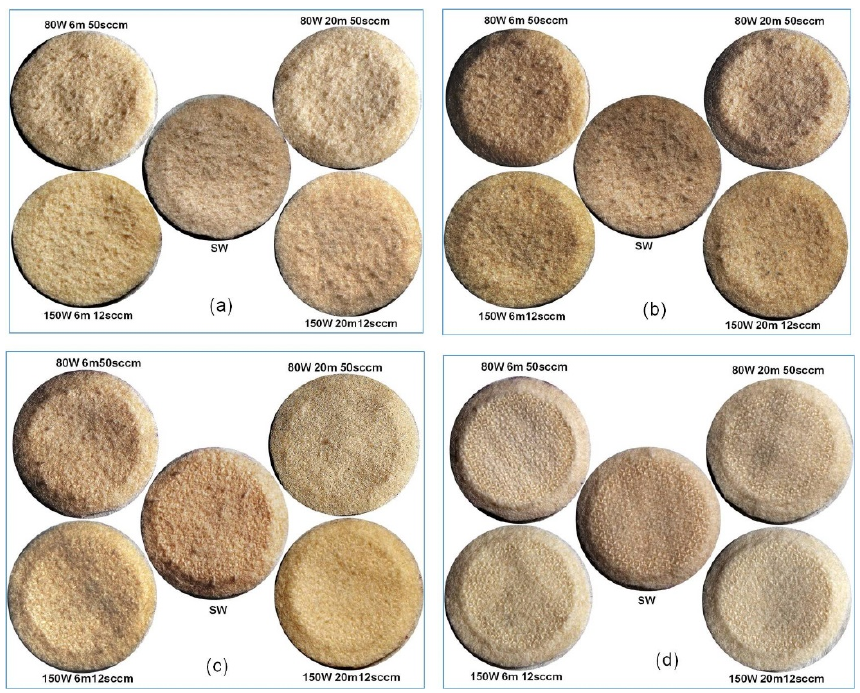
Figure 2. Effect of abrasion cycles on the surface damage of scoured wool fabrics: ( a ) 500 cycles, ( b ) 1500 cycles, ( c ) 3000 cycles, and ( d ) 10,000 cycles.